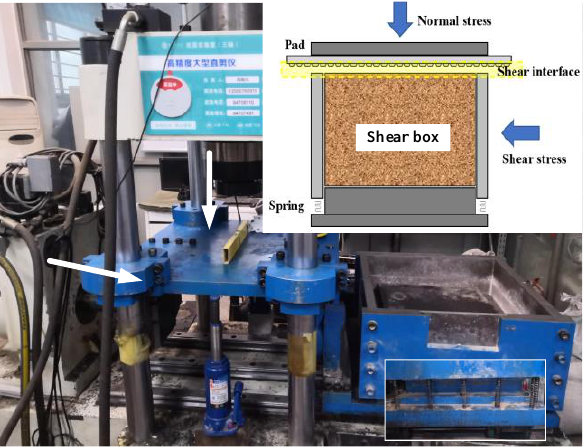
Figure 1. Large-scale shear